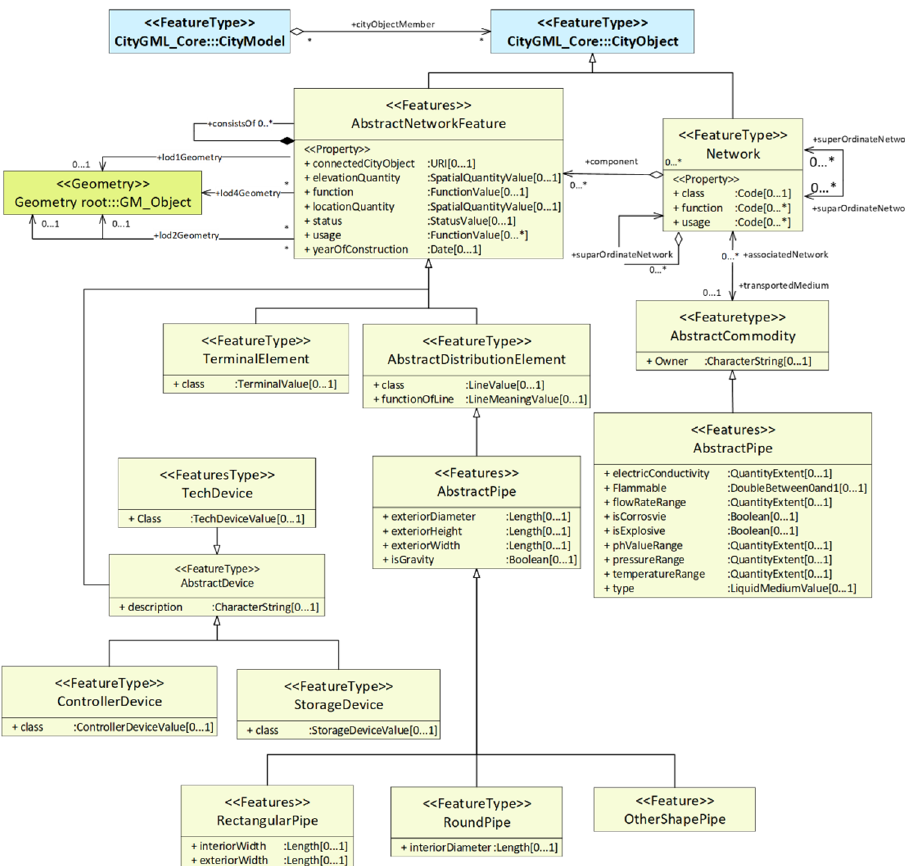
Figure 7. UML class diagram showing employment of the CityGML utility network core module for the sewer and water supply network. Note: “*” UML notation used to representation the cardinal relationship among CityGML classes that shows the number of occurrence or